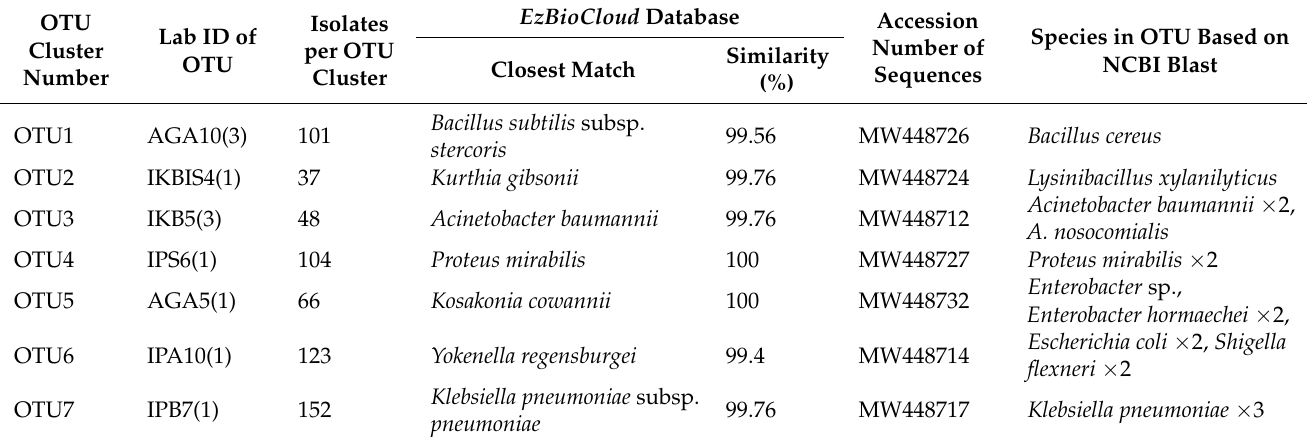
Table 2. Phylogenetic similarities of 16S rRNA gene operational taxonomic units (OTU) of isolates from ready-to-eat foods vended in Lagos,